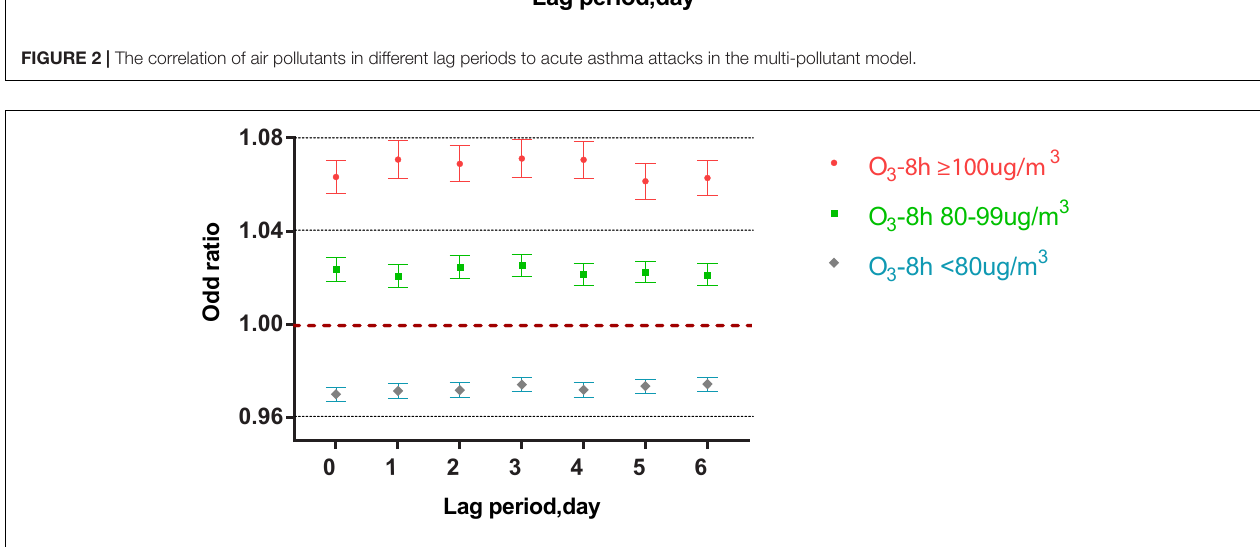
FIGURE 3 | Different O 3 -8 h levels in different lag periods in the single pollutant model.